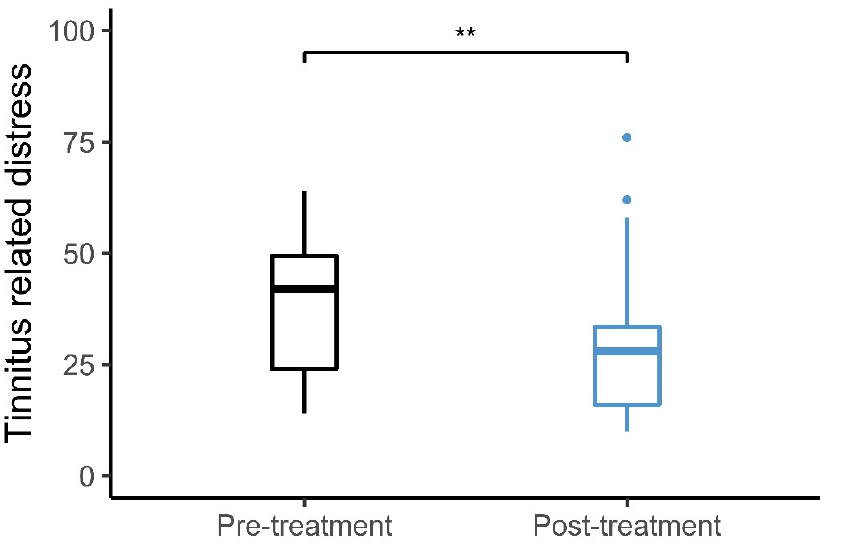
Figure 6. Tinnitus distress. Average THI scores pre- and post- long-term treatment with sound therapy. ** p < 0.01.